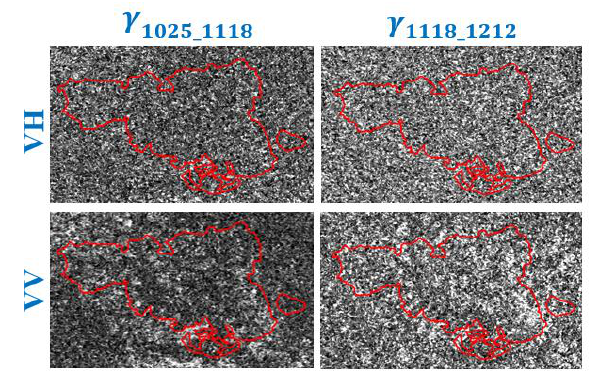
Figure 5. Coherent 𝛾 1025_1118 and 𝛾 1118_1212 between 25Oct (pre-event) and 18Nov (during event), 18Nov and 12Dec (post- event) are demonstrated on the two columns by different polarizations.